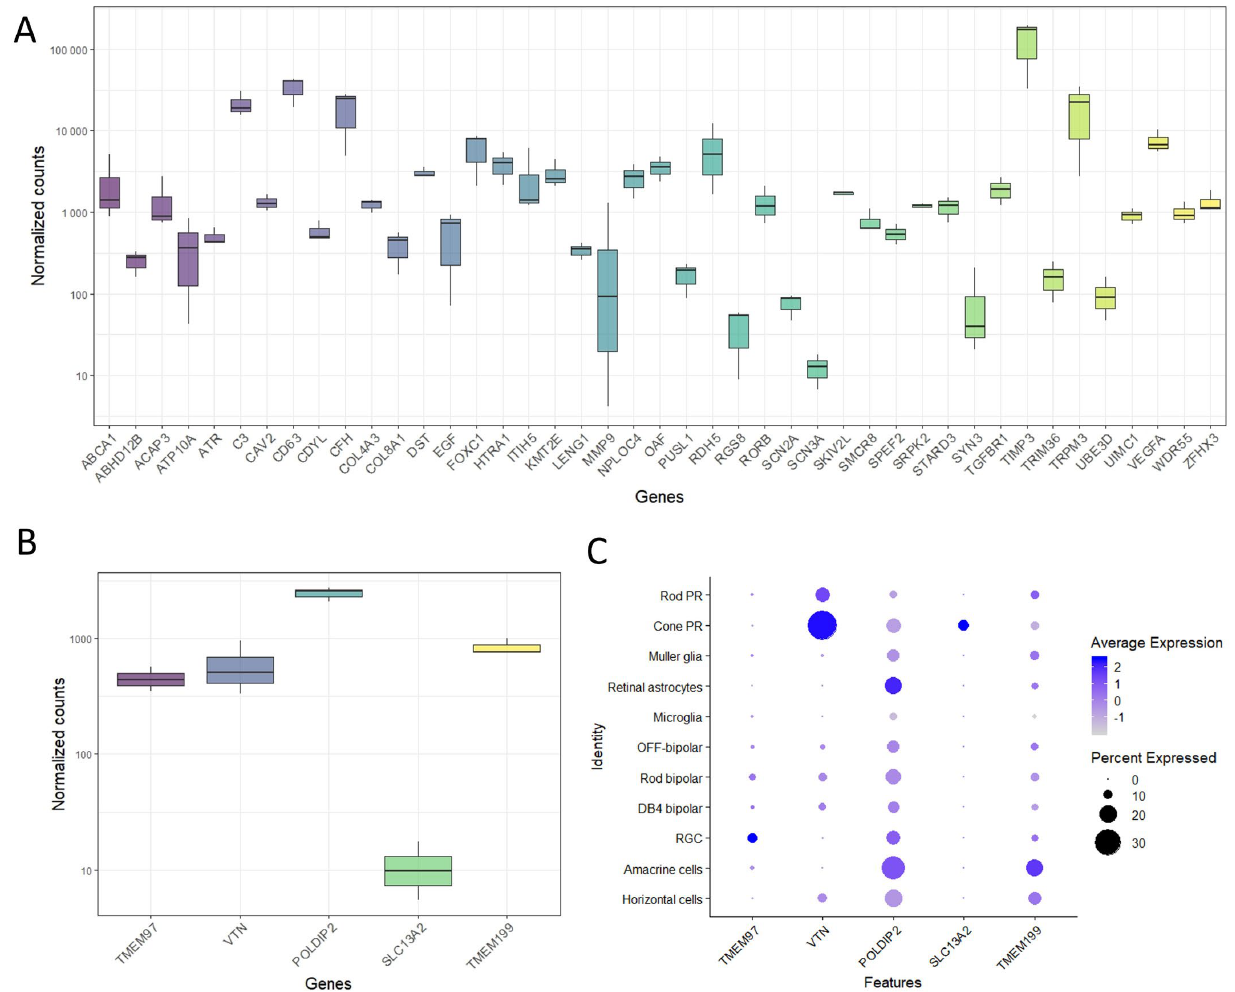
Figure 2. Expression of AMD-associated genes in human retina. ( A ) Bulk RNAseq results demon- strated expression of selected AMD-associated genes in human RPE/choroid ( n = 3 donors). Expres- sion levels of genes in the TMEM97/VTN locus in ( B ) human RPE/choroid as shown by bulk RNAseq, and ( C ) major retinal cells in human neural retina as shown by single cell-RNAseq ( n = 3 donors; [22]). PR: photoreceptors; RGC; retinal ganglion cells.